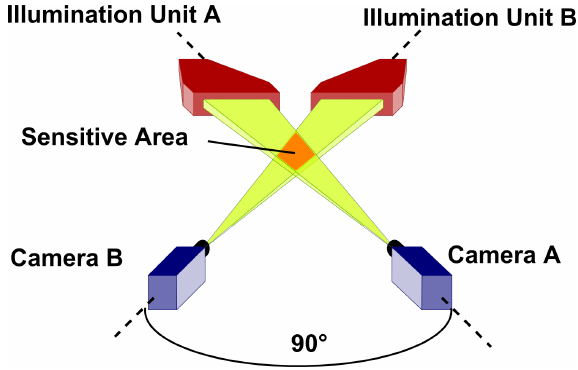
Figure 2. Measurement principle of the 2-DVD (modified from Kruger and Krajewski,